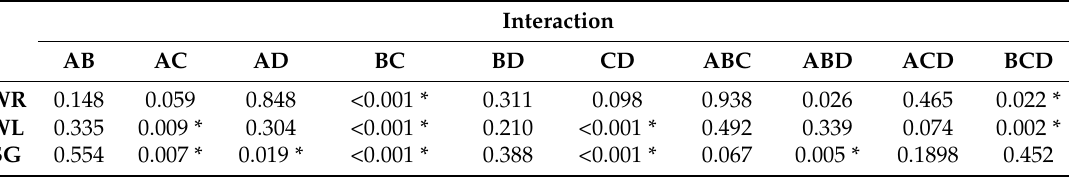
Table 2. Interactions between tested variables for WR, WL and SG expressed by p